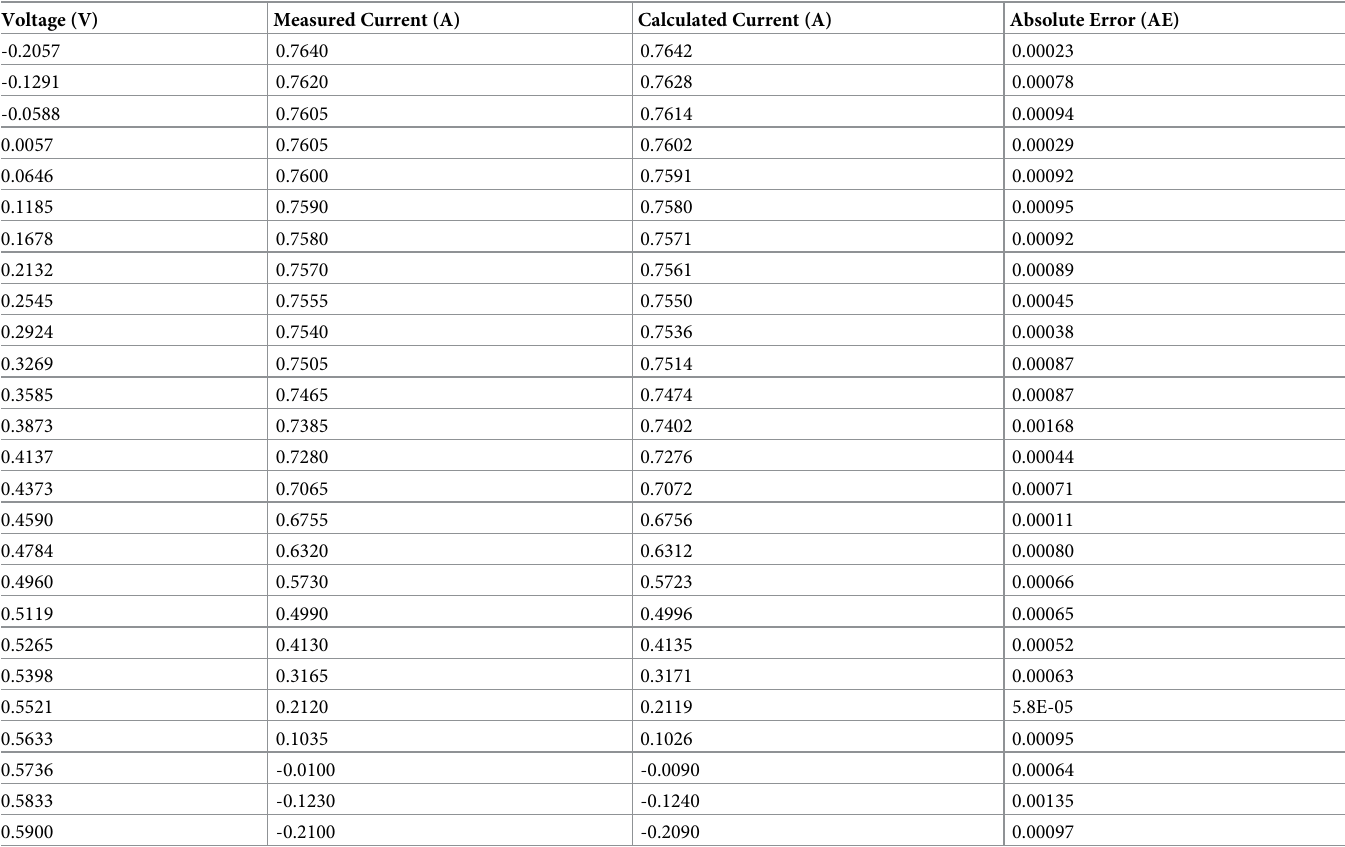
Table 1. Calculated/simulated results for single-diode model of R.T.C. France solar cell obtained using ACT. Voltage (V) Measured Current